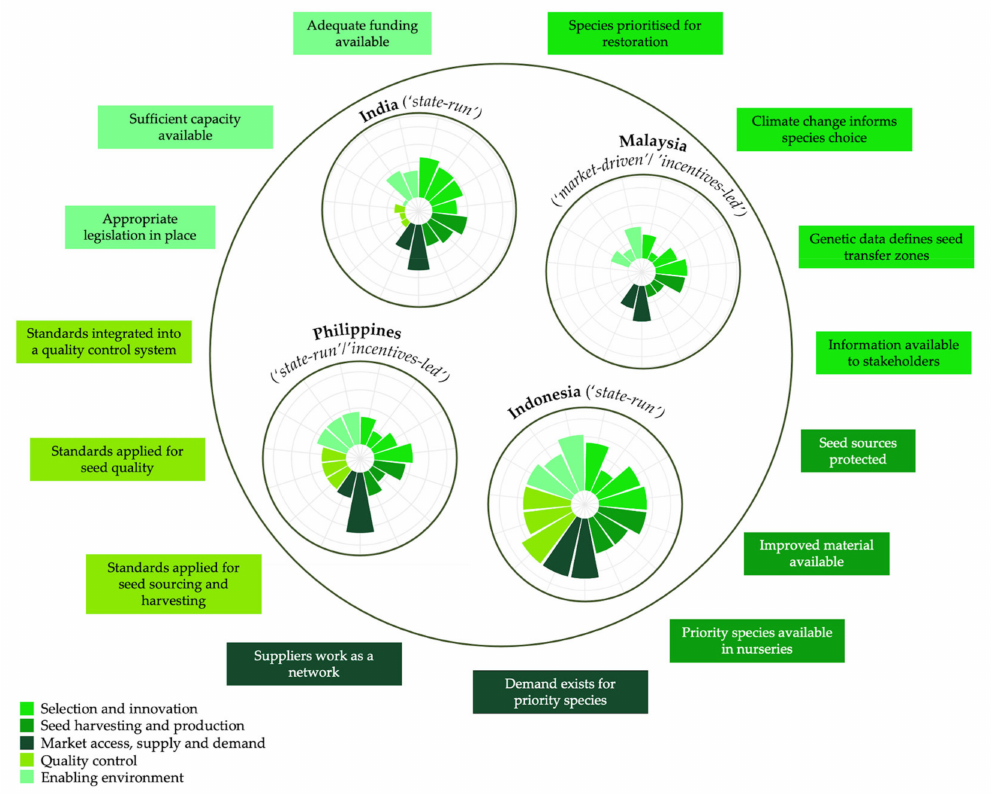
Figure 1. Radar charts illustrating the scores assigned to the 15 seed system indicators for the countries analysed (Philippines, Indonesia, Malaysia and India). The results are colour-coded by the five components (selection and innovation, seed harvesting and production, market access, supply and demand, quality control and enabling